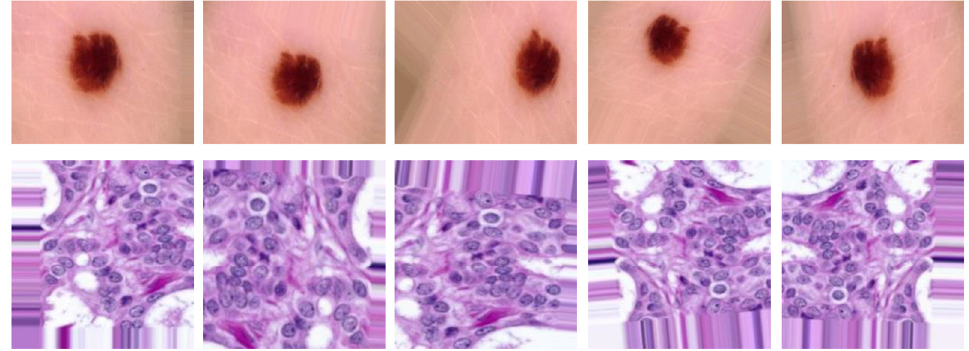
Figure 10. Examples of the applied data augmentation techniques.